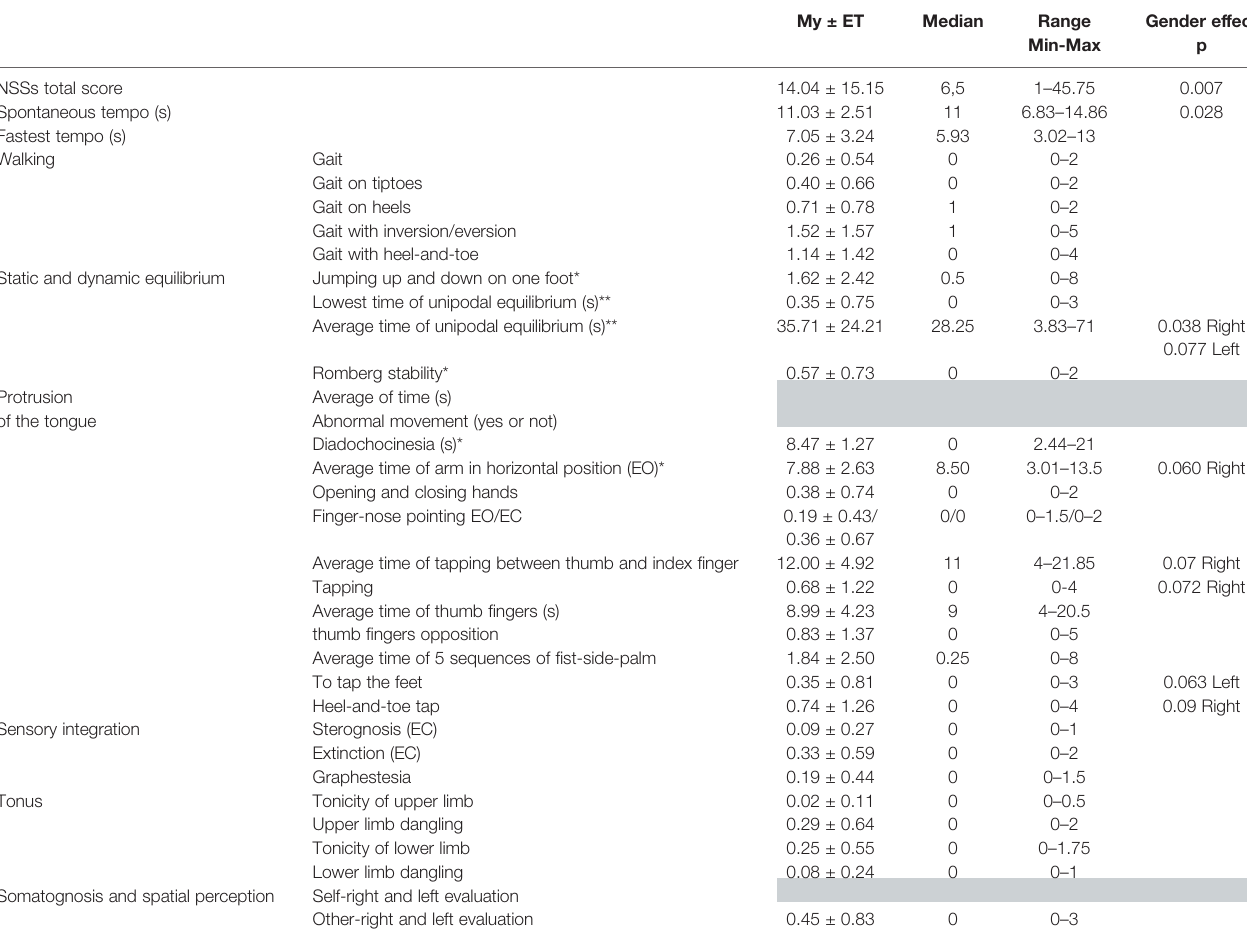
TABLE 1 | Mean scores, standard deviations (±), medians, and ranges for the main items of the PASS with signi fi cant gender effect, with left or right precision when